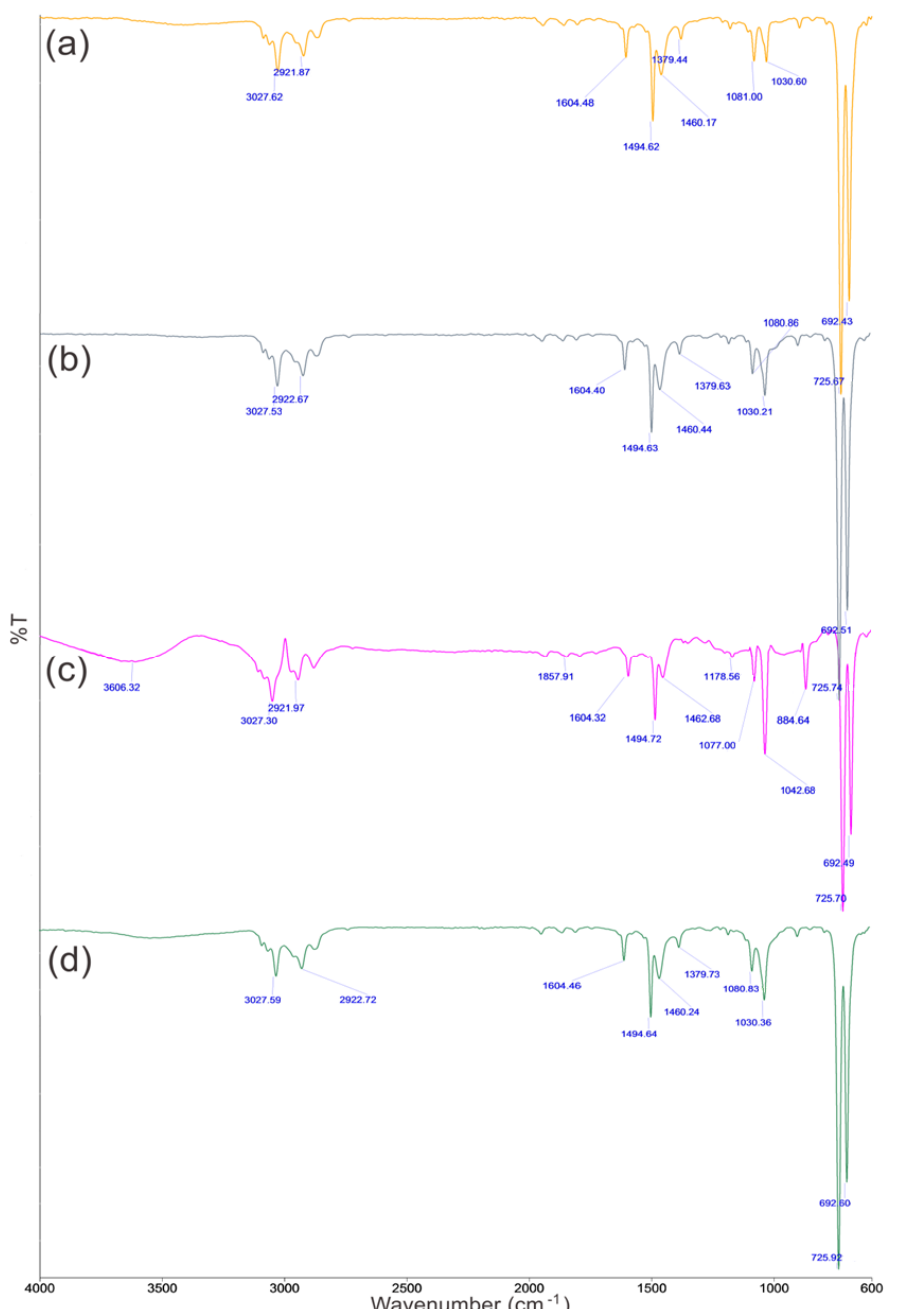
Figure 7. FTIR spectra for ( a ) Aliquat 336 in toluene, ( b ) Aliquat 336-TBP in toluene, ( c ) Cd(II) ions loaded Aliquat 336 and ( d ) spent Aliquat 336 after stripping.